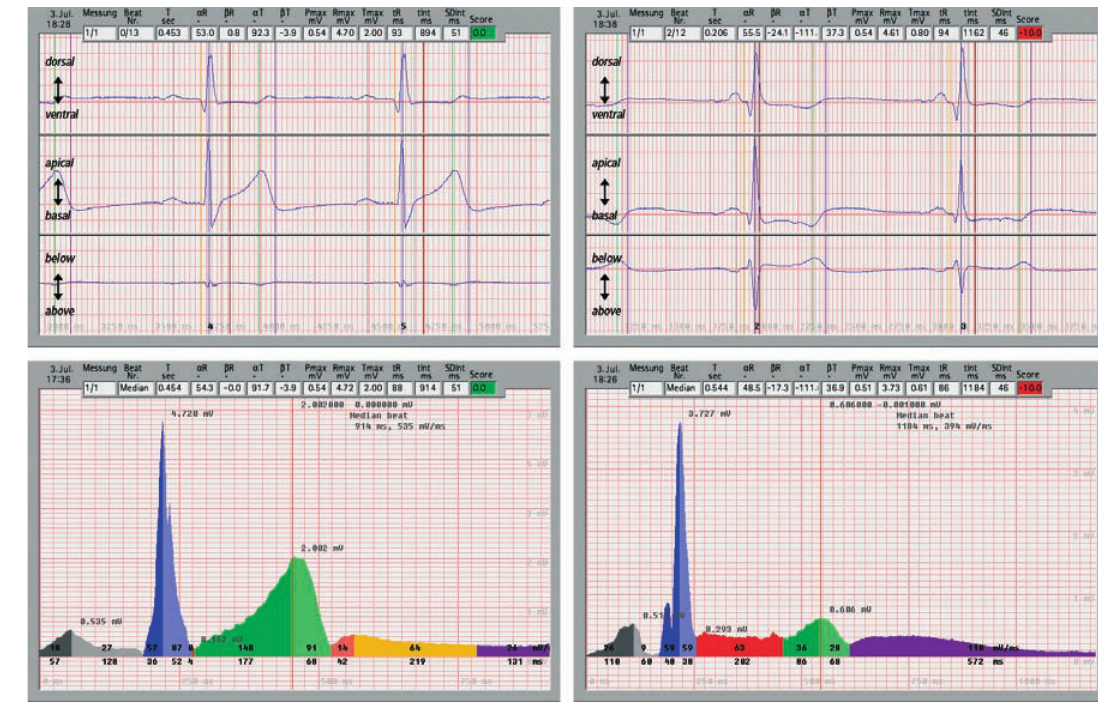
Figure 4 Traces from a healthy person (left) and a patient with myocardial ischaemia (right). Images above show the recordings of the projections of x (dorsal – ventral), y (apical – basal), and z (below – above). Images below show the time course of the median potential corresponding to the median distance of the tip of the momentary vector from the origin (abscissa in mV). Dark colours indicate potentials from the beginning of a loop to the maximum distance from the origin; light colours correspond to potentials from the maximum of the loop till its end. Potentials corresponding to the P-loop (atrial depolarisation) are shown in grey (P+ dark grey, P- light grey). Because potentials are non-vectorial and cannot be negative, the loop corresponding to the QRS-complex is designated the R-loop. The potentials corresponding to the R-loop (ventricular depolarisation) are shown in blue (R+ dark blue, R- light blue). The potentials measured after the end of the R-loop and before the onset of the T-loop are shown in red. The potentials corresponding to the T-loop (ventricular repolarisation) are shown in green (T+ dark green, T- light green). TP-potentials are shown in purple. The recording on the left side differentiates U-potentials (U+ orange, U- yellow).